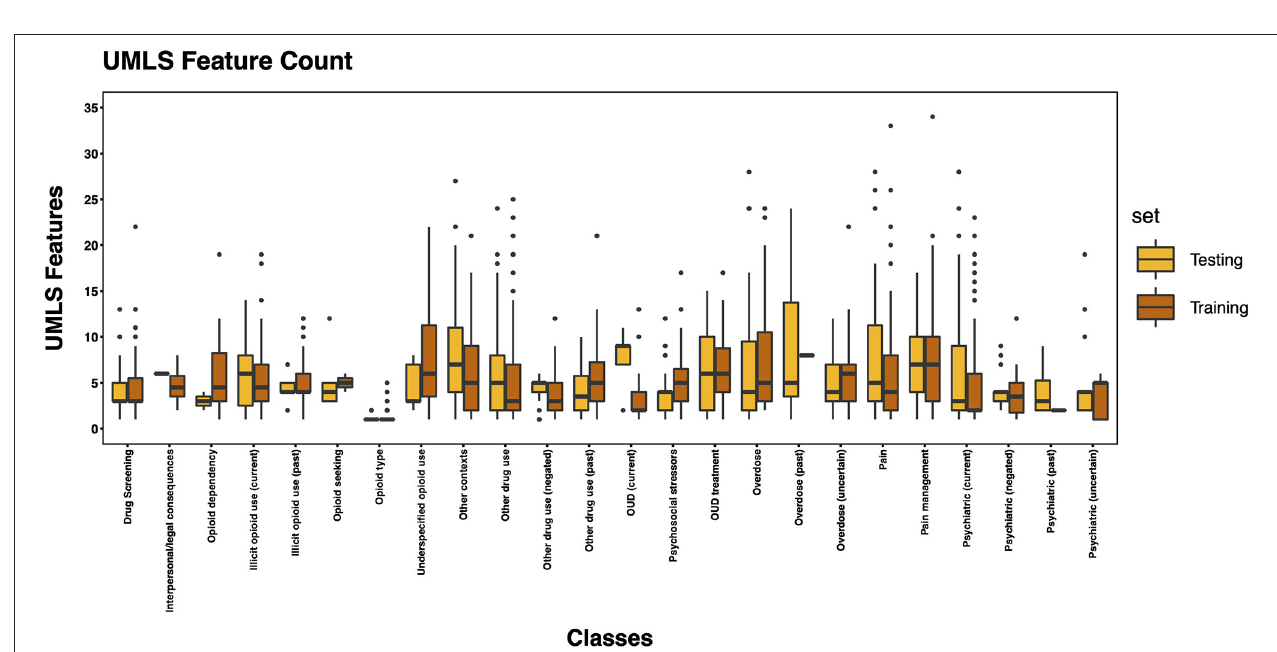
FIGURE 6 | Boxplot of the mean count of UMLS features per class, comparing training and testing sets.